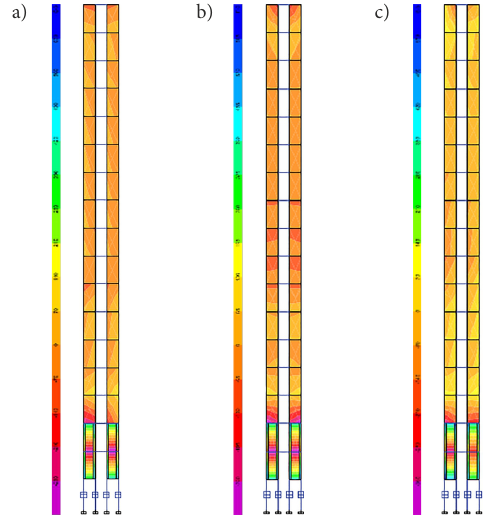
Figure 15. Stress damage comparison of core tube: a – stress damage of the core tube without considering the SSI effect; b – stress damage of the core tube of considering SSI effect (hard soil); c – stress damage of the core tube of considering SSI effect (soft soil)